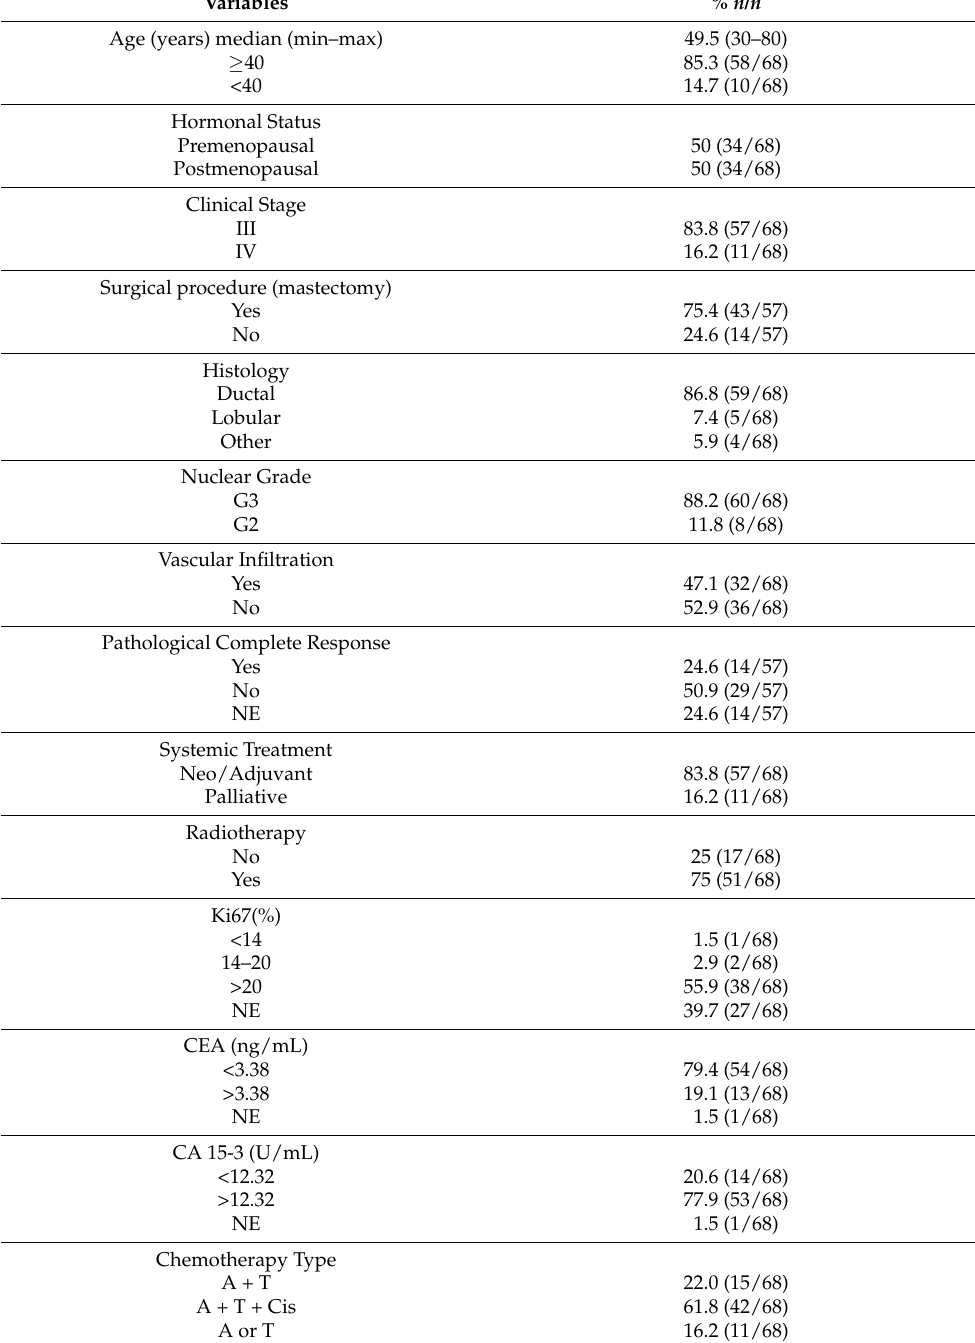
Table 1. Baseline Clinical and Pathological Characteristics of Patients ( n =